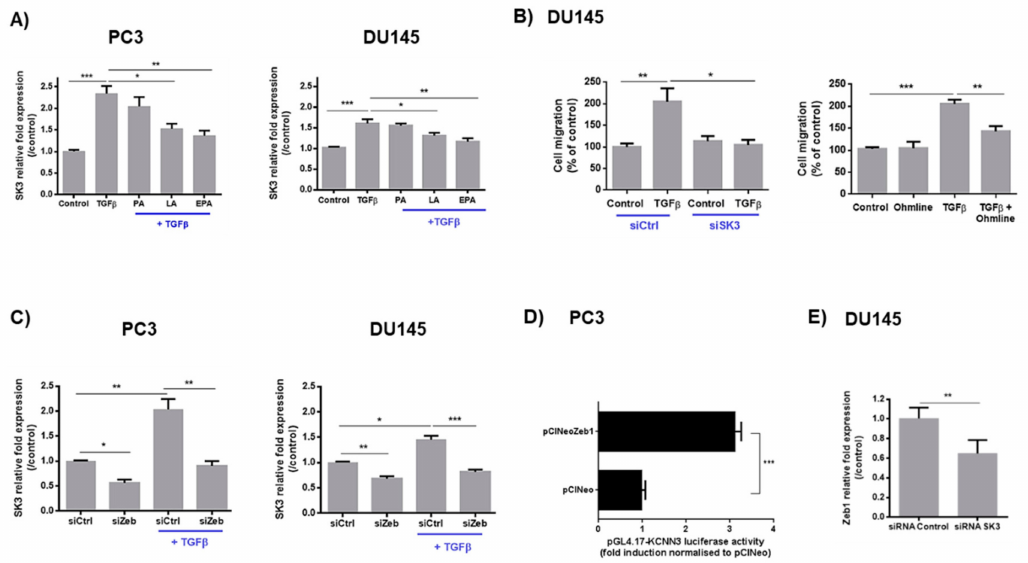
Figure 3. LA and EPA inhibit SK3 expression induced by TGF β , and SK3 is dependent on